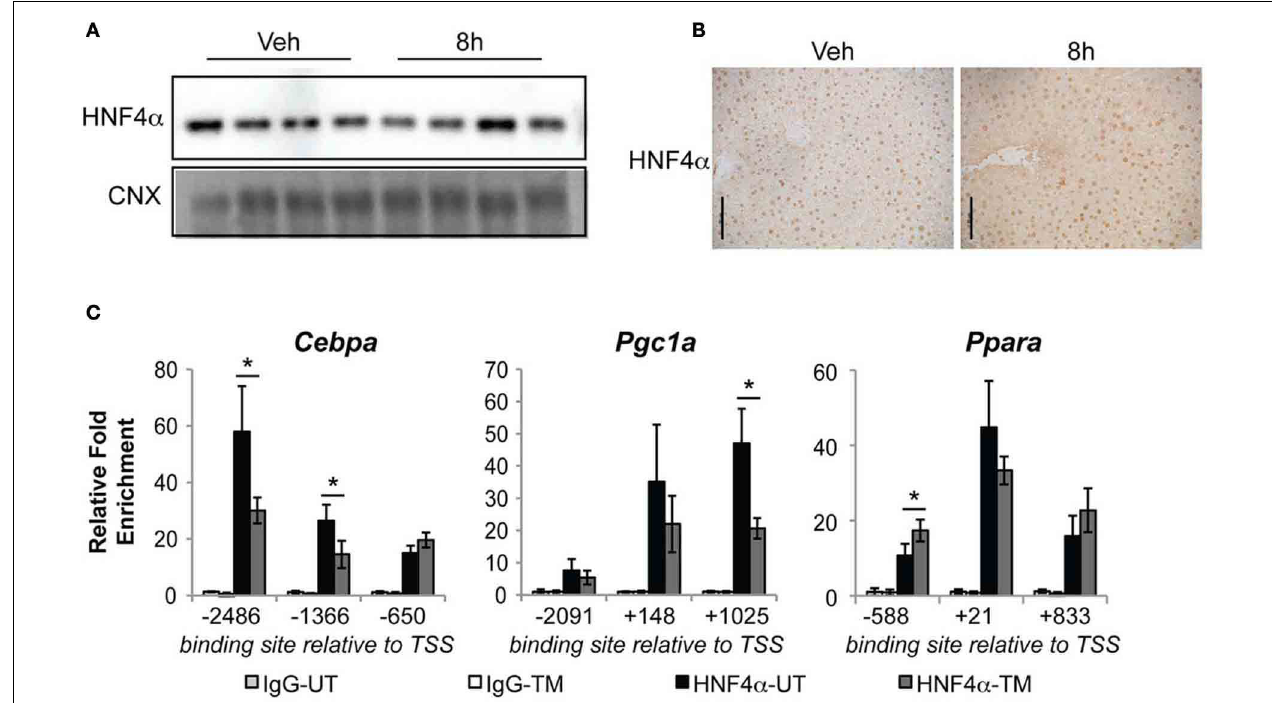
FIGURE 7 | Diminished HNF4 α binding at Cebpa and Pgc1a promoters during ER stress. (A,B) Wild-type mice were challenged with 1mg/kg TM for 8h, and expression of HNF4 α was assessed by immunoblot (A) or immunohistochemistry (B) . Scale bar = 50 μ m. (C) HNF4 α binding to the regulatory regions of the indicated genes was